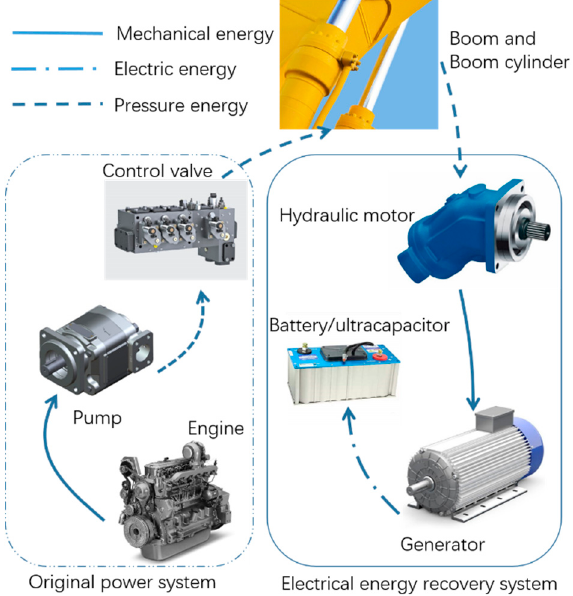
Figure 1. Schematic of hydraulic excavator boom system equipped with an electrical energy recovery system.